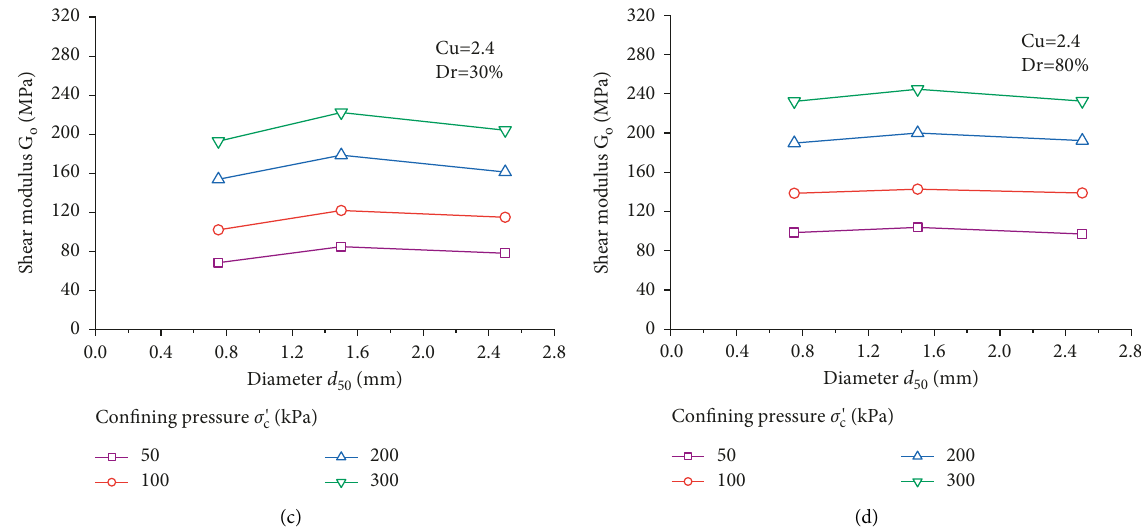
Figure 7: Maximum shear modulus G � 1.2, Dr � 30%; (b) Cu � 1.2, Dr � 80%; (c) Cu � 2.4, Dr � 30%; (d) o and median diameter d 50 . (a) Cu Cu � 2.4. Dr �